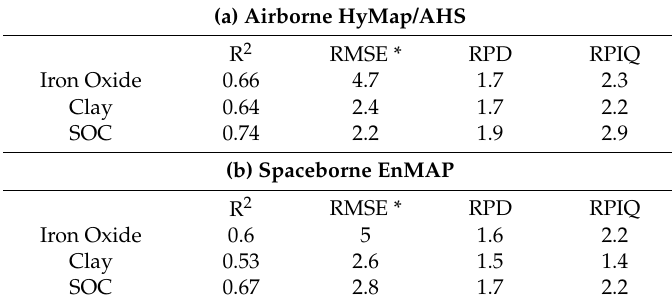
(cid:1) 1 (cid:4) kg for iron